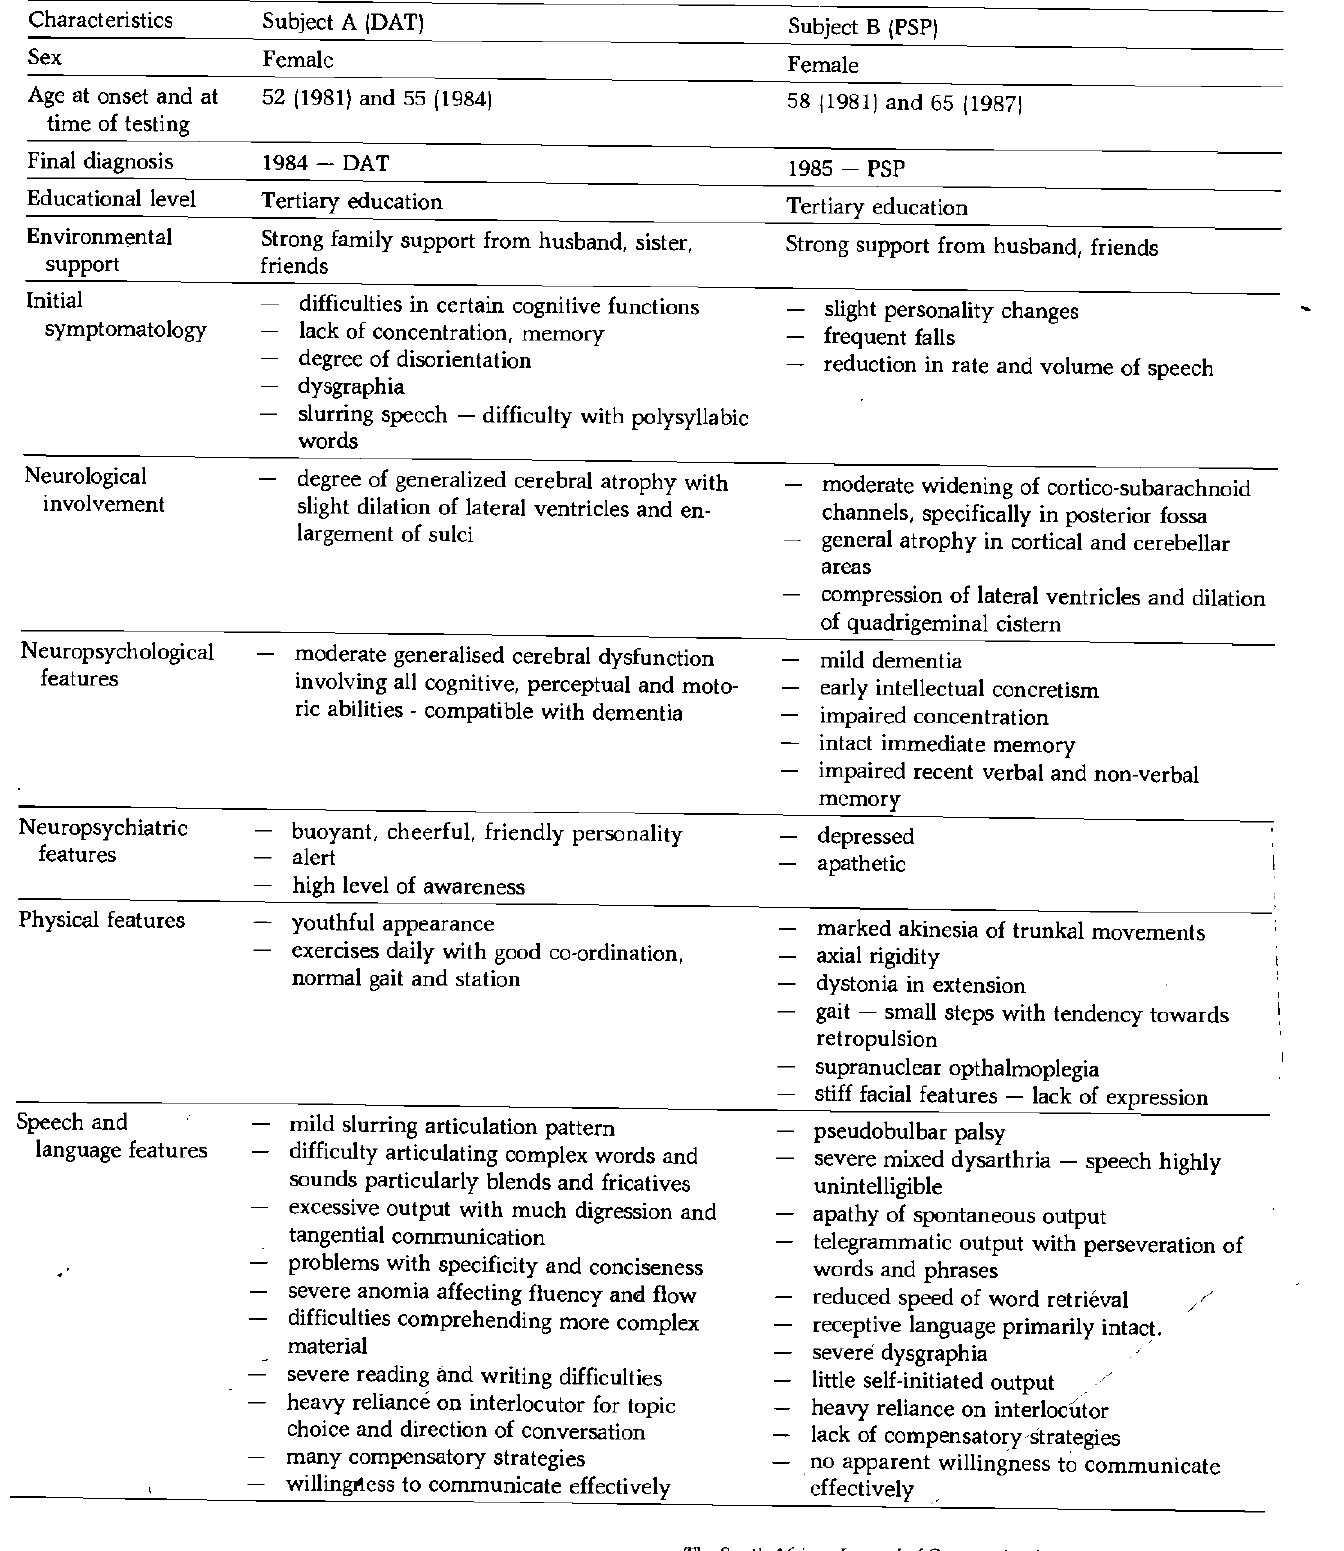
Table II: Subject characteristics and performance on standardized tasks